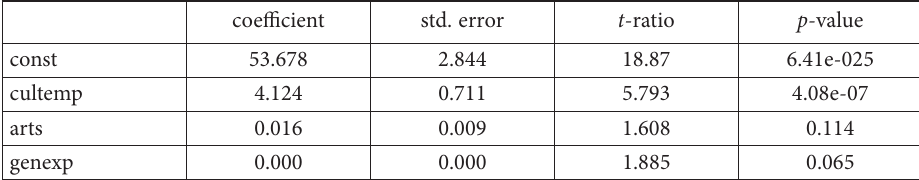
Table 10. 2018–2020 panel regression analysis (source: compiled by the